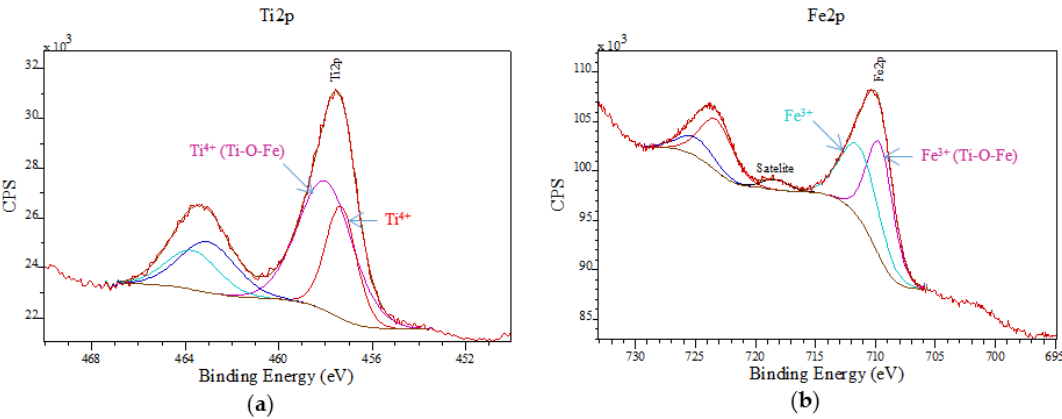
Figure 5. X-ray photoelectron spectroscopy (XPS) spectra of 5% TiO 2 -MAGSNC photocatalysts: ( a ) Ti 2p; and ( b ) Fe 2p.